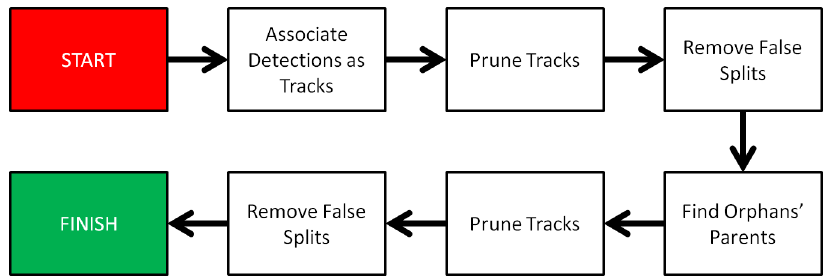
Figure 10. Flowchart illustrating process for automatically tracking cells, with lineage constraints.